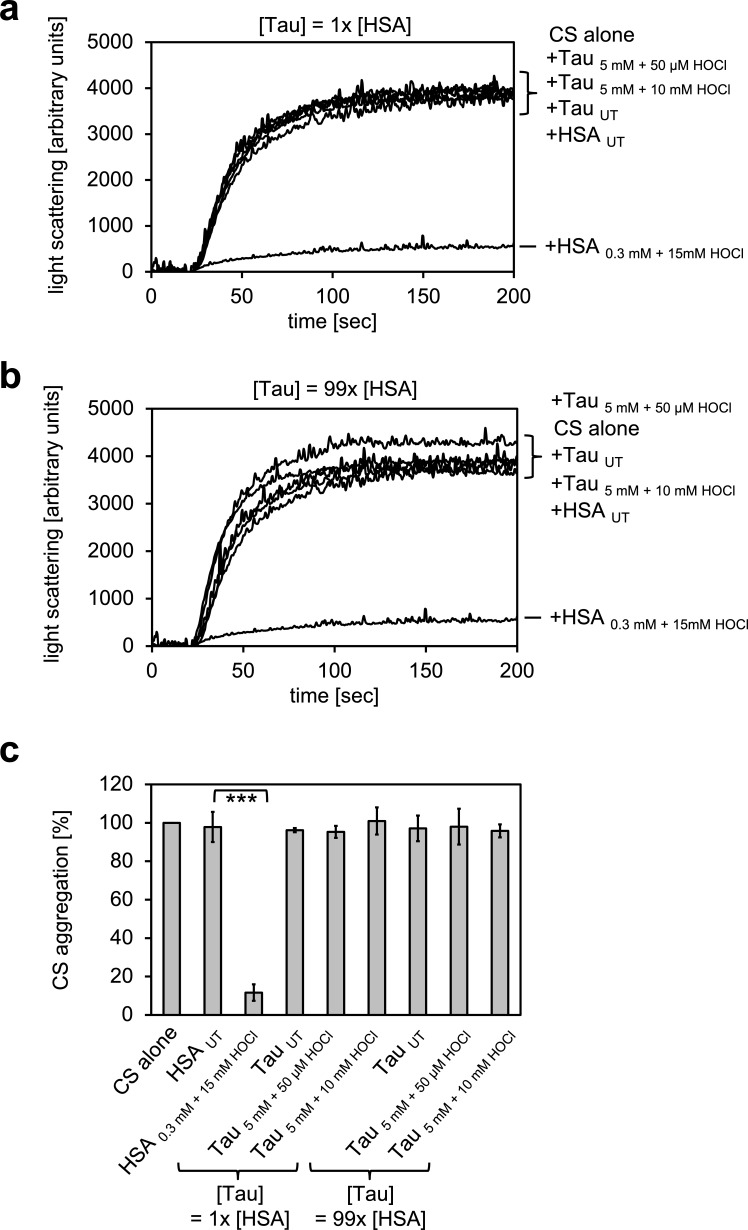
Taurine N-chloramine, a model N-chloramine does not affect our light-scattering assay.Taurine monochloramine was generated by incubation of 5 mM taurine with 50 µM HOCl. Taurine dichloramine was generated by incubation of 5 mM taurine with 10 mM HOCl. Untreated taurine or taurine treated with the different amounts of HOCl was added at the same concentration as HSA (1x) or a concentration comparable to the concentration of chlorinated nitrogen atoms in HSA assuming that all Lys, Arg, His and Trp residues as well as the N-terminus were chlorinated (99x). Taurine N-chloramine did not affect the citrate synthase aggregation assay. In a and b representative measurements are shown. In c data are represented as means and standard deviations from three independent experiments. Student’s t-test: ***p<0.001. Aggregation of citrate synthase in the absence of HSA or taurine was set to 100% and all the data are presented as percentage of this control. Labels of aggregation curves are written in the order of the final intensity of light scattering of the respective treatment.
10.7554/eLife.47395.012Figure 2—figure supplement 4—source data 1.Numerical light scattering data obtained during protein aggregation assays represented in Figure 2—figure supplement 4.